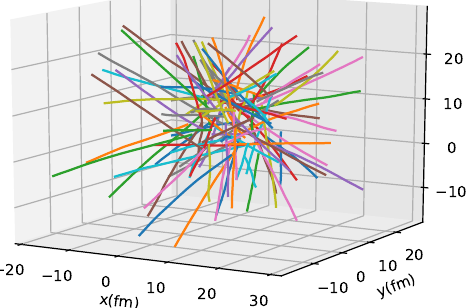
Figure 10 . Example of random trajectories of (cid:12)fty heavy quark-antiquark pairs. The pairs are prepared as explained in the text, and evolve during a time t = 5 fm =